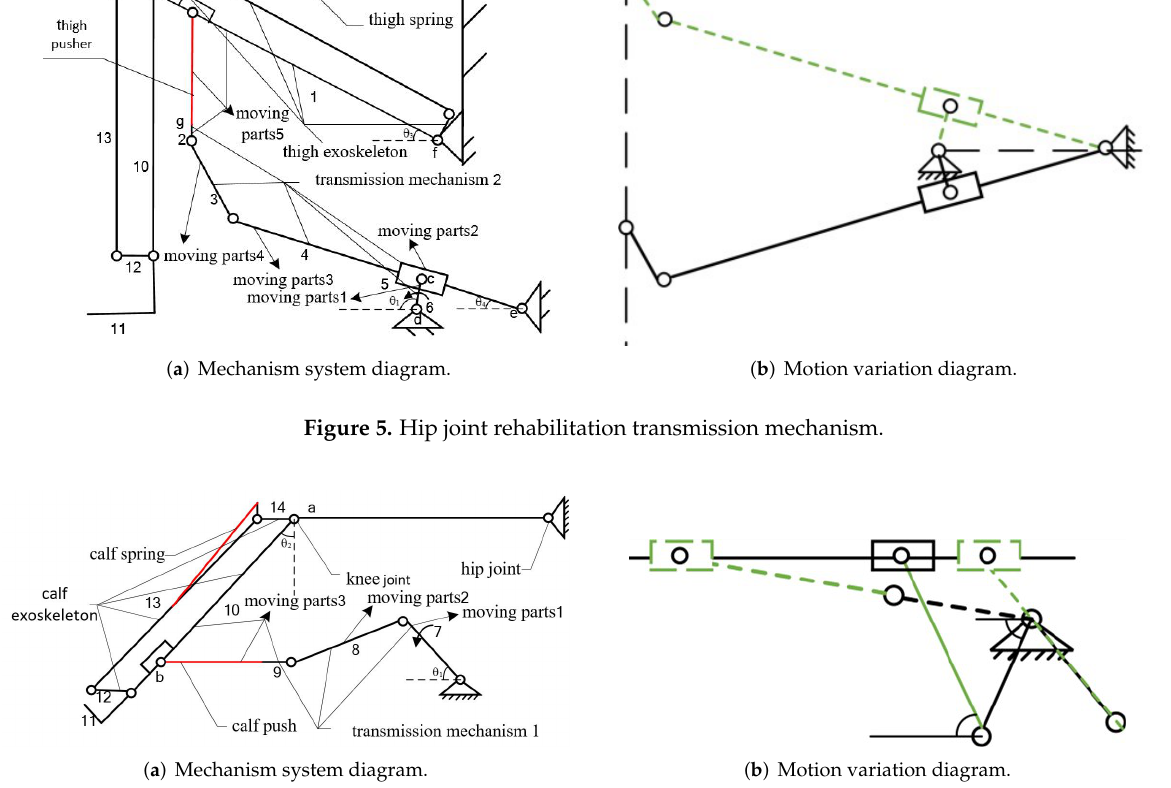
Figure 6. Knee joint rehabilitation transmission